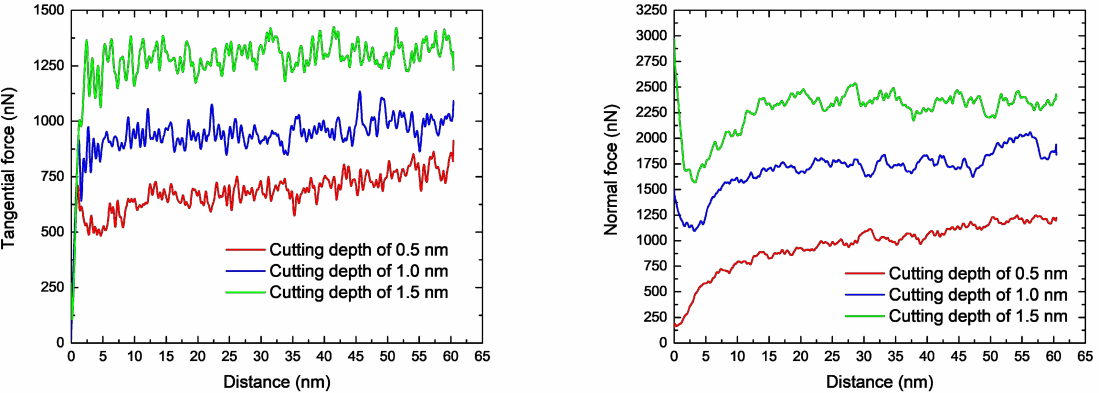
Figure 9. Tangential force and normal force of the cutting with different cutting depths.